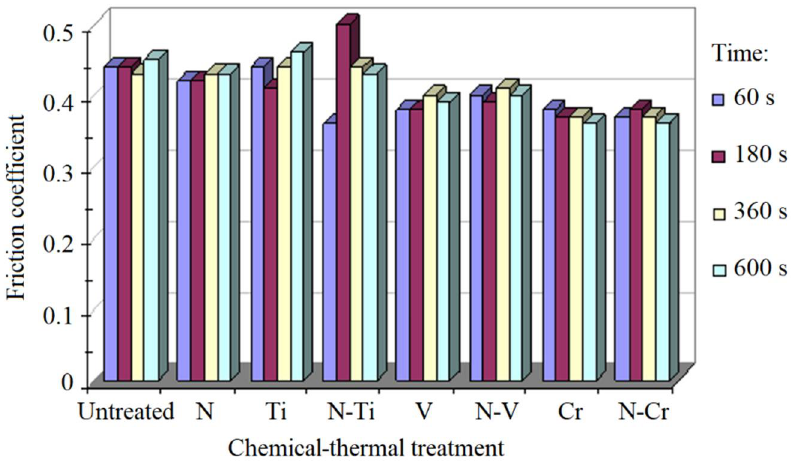
Figure 10. The dependence of friction coefficient for the contact pair “steel DIN C80W1—steel DIN 66Mn4“after different treatment modes on time under conditions of sliding friction without lubrication.